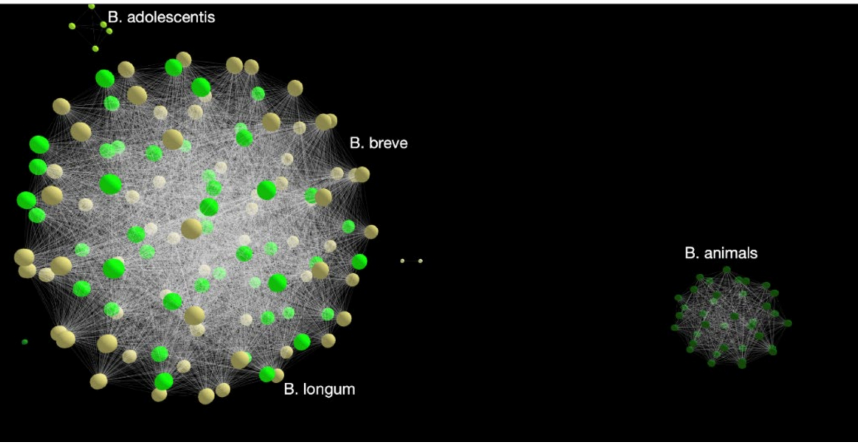
Figure 6. Example of a Bifidobacterium